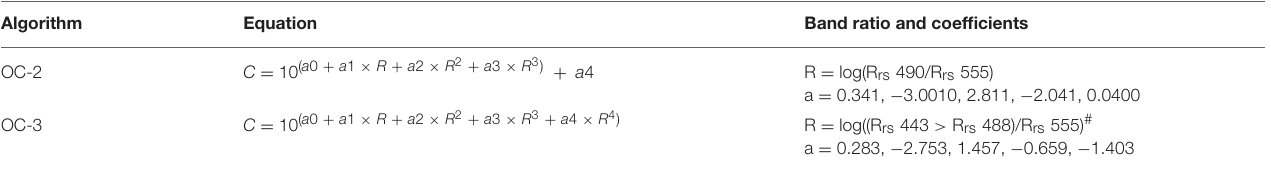
TABLE 1 | Details of the empirical algorithms used for the study (Source: OC-2: O’Reilly et al., 1998; OC-3: Morel and Maritorena, 2001, with OC-3 coefficients for Bay of Bengal from Sarangi, 2016). Algorithm